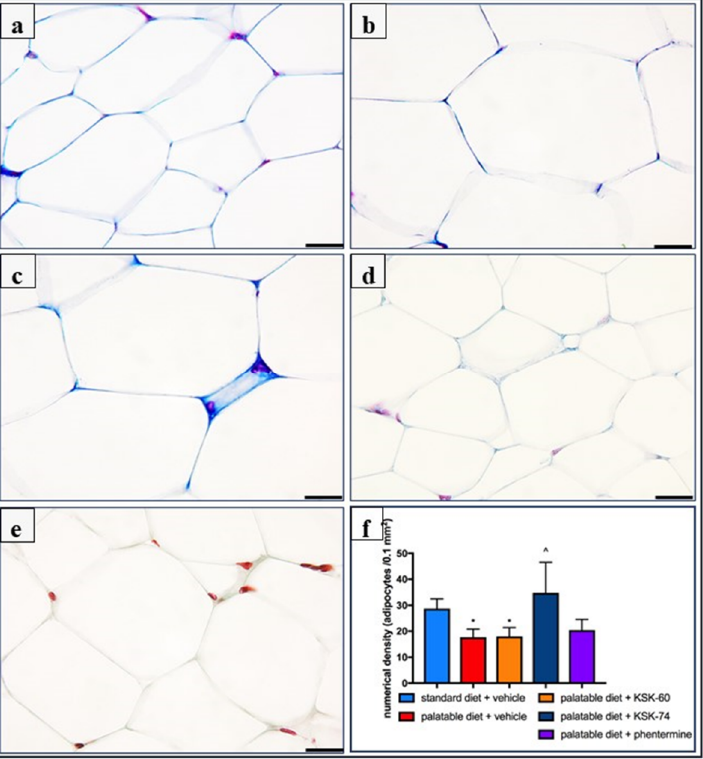
Figure 7. Adipocytes numerical density in Masson’s trichrome staining of adipose tissue from the studied groups of rats. Representative microphotographs of tissue sections from the standard diet + vehicle group showing the normal architecture of adipocytes ( a ); palatable diet + vehicle ( b ) and palatable diet + KSK-60 10 mg/kg ( c ) showing a decrease in the number of adipocytes per 0.1 mm 2 ; palatable diet + KSK-74 10 mg/kg ( d ), which has more adipocytes compared to palatable diet + vehicle; and palatable diet + phentermine 7 mg/kg ( e ). Bar = 20 mm. ( f ) Adipocytes’ numerical density expressed as means ± SD, n = 6. Comparisons were made using the Kruskal–Wallis test followed by the Dunn post hoc test; * significant vs. standard diet + vehicle group; ^ significant vs. palatable diet + vehicle group * ^ p < 0.05.